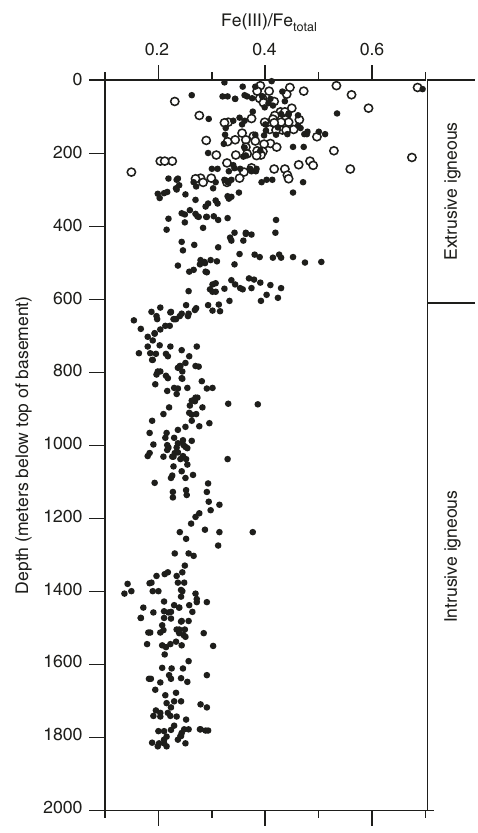
fi le of Fe oxidation ratio [Fe(III)/Fe total ] as function of basement depth. Fe total = Fe(III) + Fe(II). Higher ratios of Fe(III)/Fe total show that a larger fraction of the total Fe is oxidized. Filled circles mark data from DSDP Hole 504B. Open circles mark data from ODP Hole 896 A. All data from Alt et al. 20 . Figure modi fi ed from Alt et al.